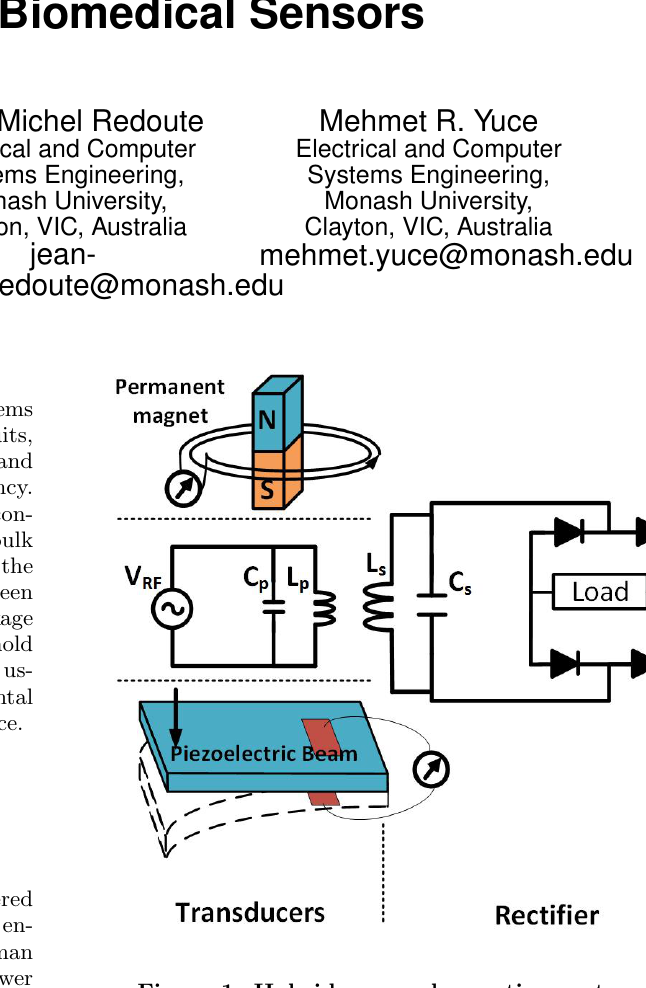
Figure 1: Hybrid energy harvesting